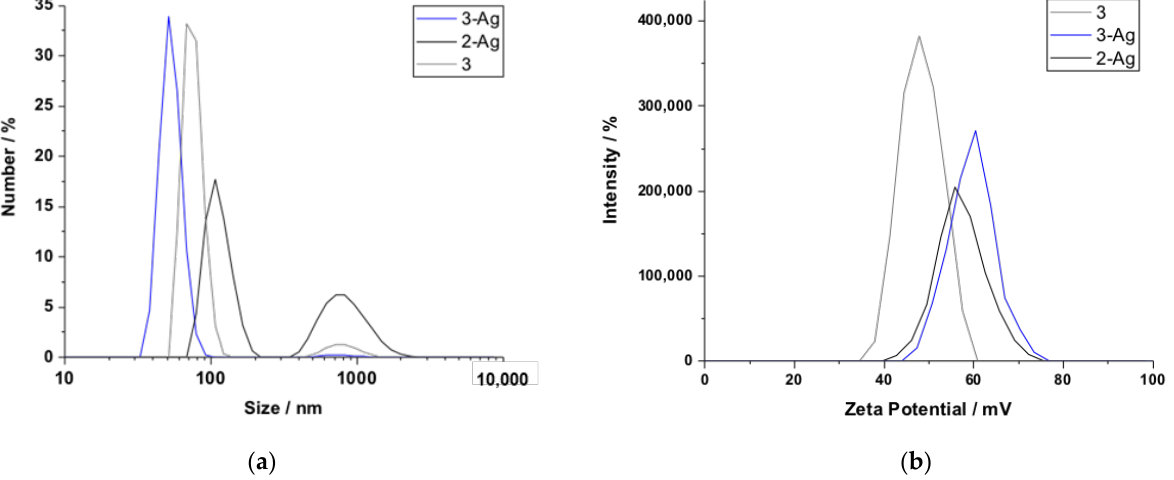
Figure 6. Results of ( a ) colloidal size distribution measurements by DLS and ( b ) ζ -Potential measurements for the colloidal solutions: CS/GA/TA/AgNPs (3-Ag) in blue, CS/TA/AgNPs (2-Ag) in dark grey, control CS/GA/TA (3) in light grey.